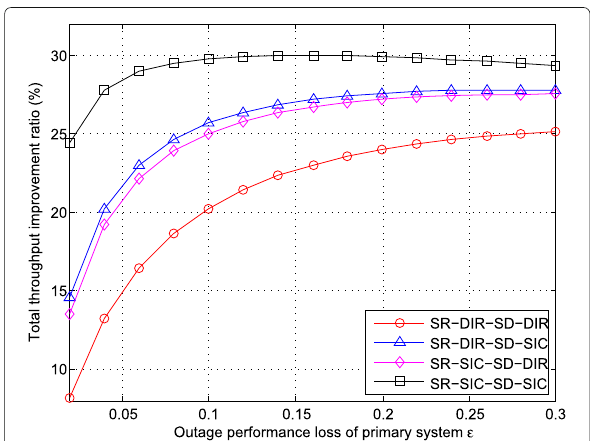
Fig. 17 Throughput improvement ratio vs the outage